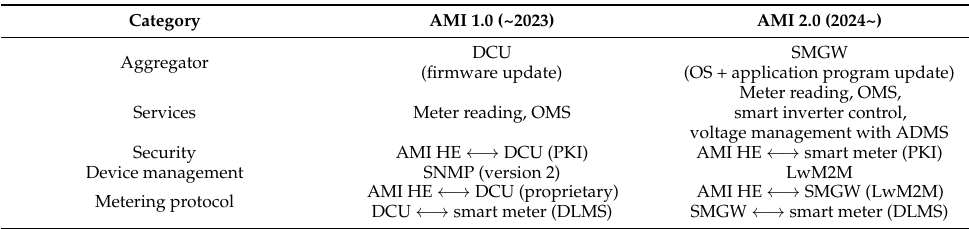
Table 1. Function comparison between KEPCO AMI 1.0 and